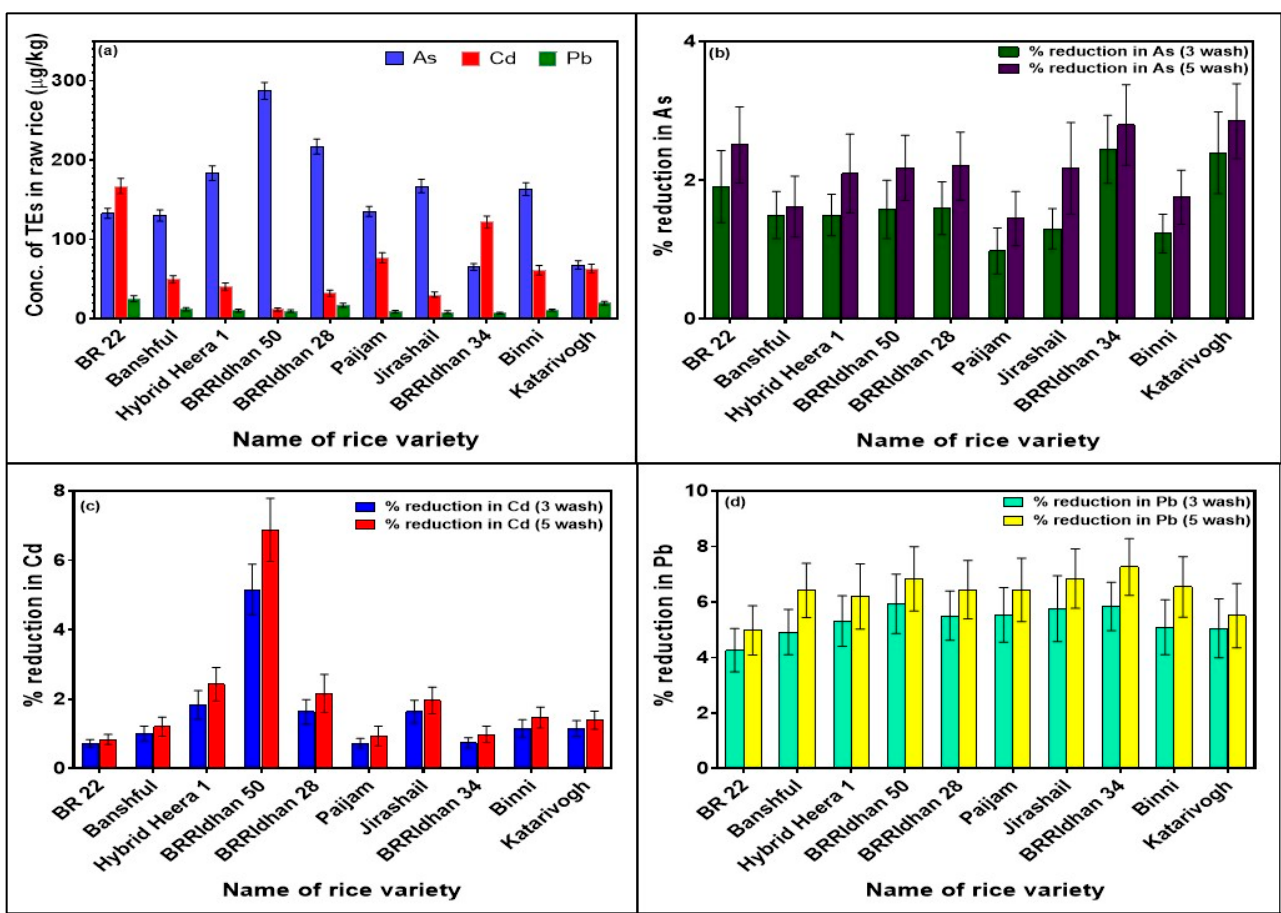
Figure 1. ( a ) Concentrations of TEs (As, Cd, and Pb) in raw rice; and effect of various washing procedures on percentage of reduction in TEs: ( b ) As, ( c ) Cd, and ( d ) Pb from raw